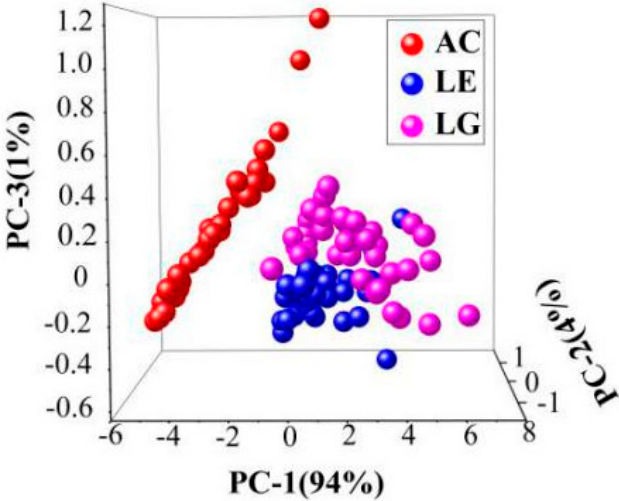
Figure 3. Cluster analysis of origins of honey from three botanical origins. (AC, LE, and LG represent acacia, linen, and longan separately). Acacia honeys can be clearly distinguished from linen and longan honeys, and the results of the cluster between linen and longan honeys are closed.